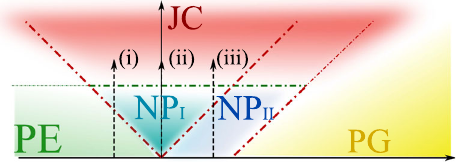
FIG. 2. Parameter space of the boson impurity model as a function of Ω and Δ . Different colors denote regimes with different EBS origin: perturbative excited (PE, green), perturba- tive ground (PG, yellow), nonperturbative (NP, blue), and Jaynes- Cummings (JC, red). The boundaries between these regimes are not sharp and depend on the excitation number N . See the main text for more details. For the one-dimensional tight-binding model with cos ð k Þ spectrum, the NP regime is further divided into two subregimes NP and NP (light and dark tones) I II characterized by different scaling behaviors. The three dashed arrows (i) – (iii) denote the paths that we use in Figs. 3 and